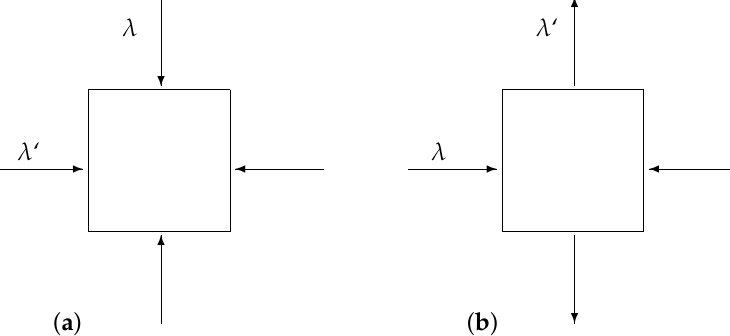
Figure 2. ( a ) Compressive load along x -parallel and along y -parallel sides. ( b ) Compressive load along y -parallel and tensile load along x -parallel sides.